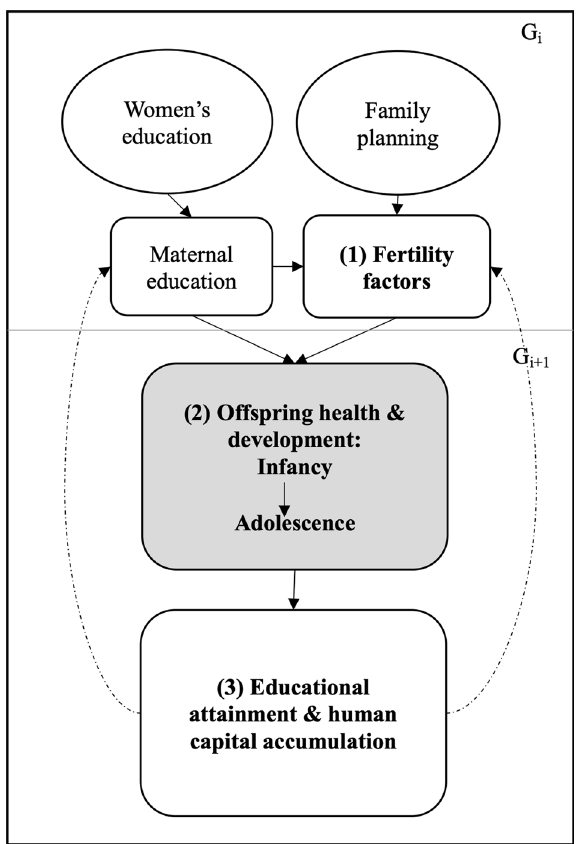
Fig. 1 Conceptual model. Intergenerational linkages between women’s education and family planning interventions, fertility decline, child health and development, and human capital